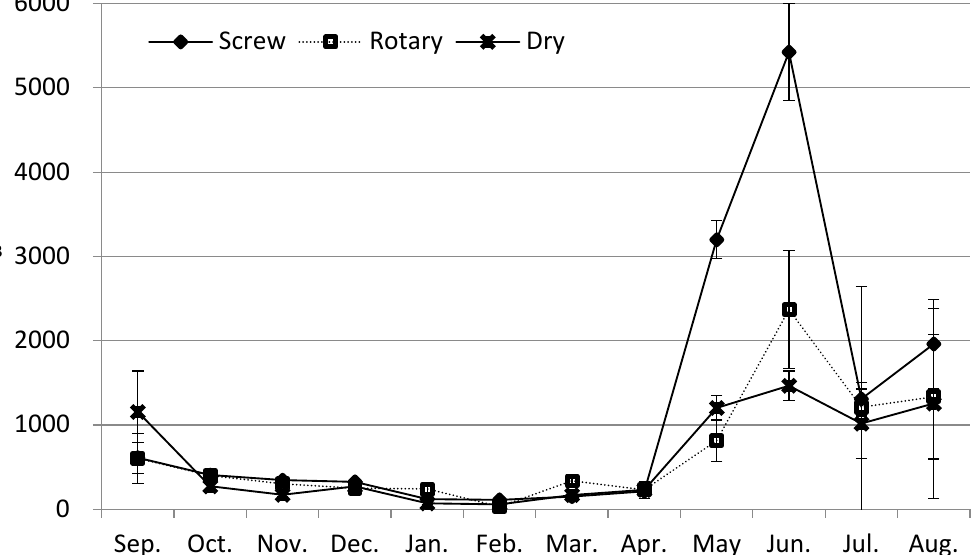
Figure 1. Monthly mean concentration trend of airborne fungi in livestock manure composting plants.